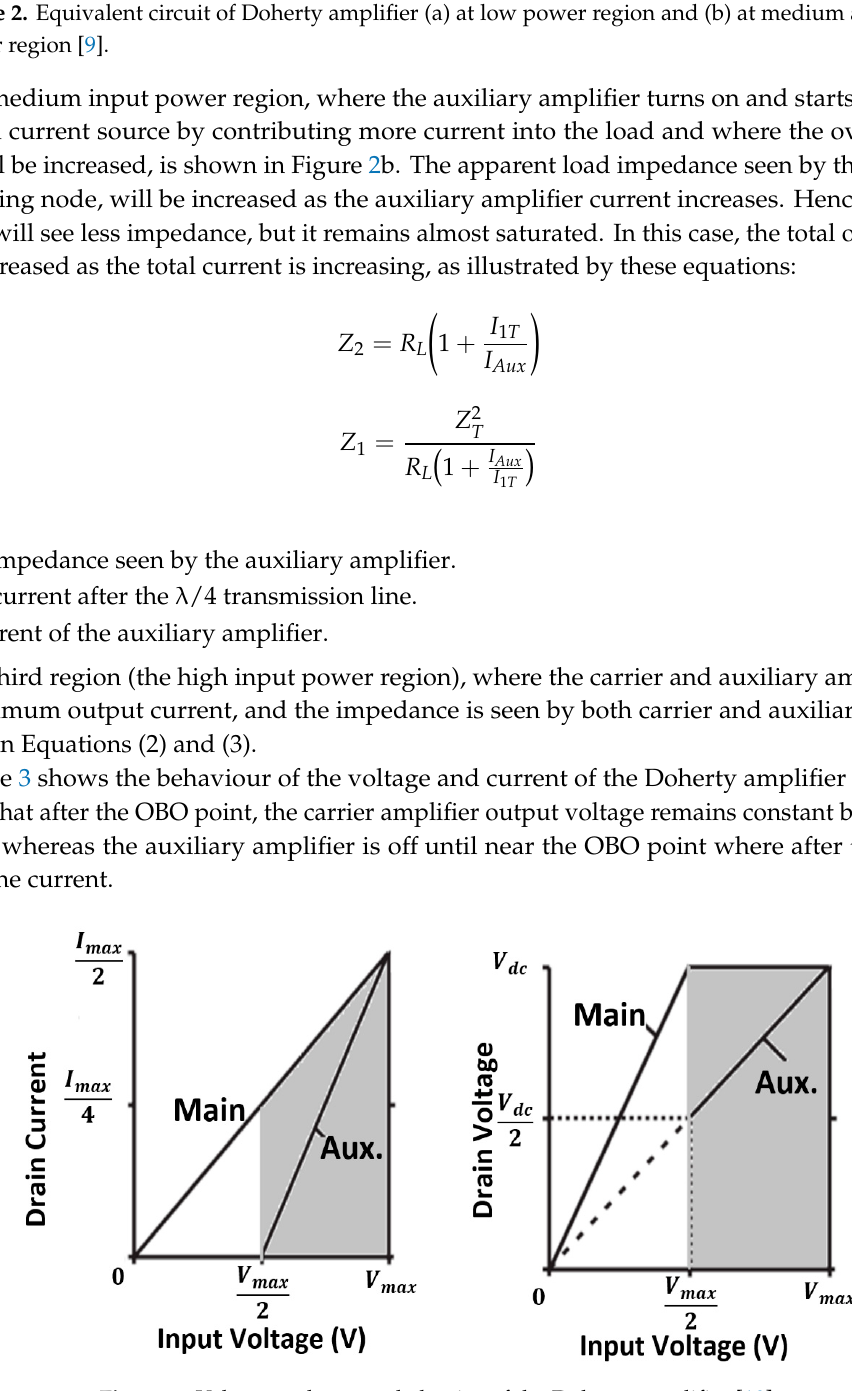
Figure 3. Voltage and current behavior of the Doherty amplifier [10].